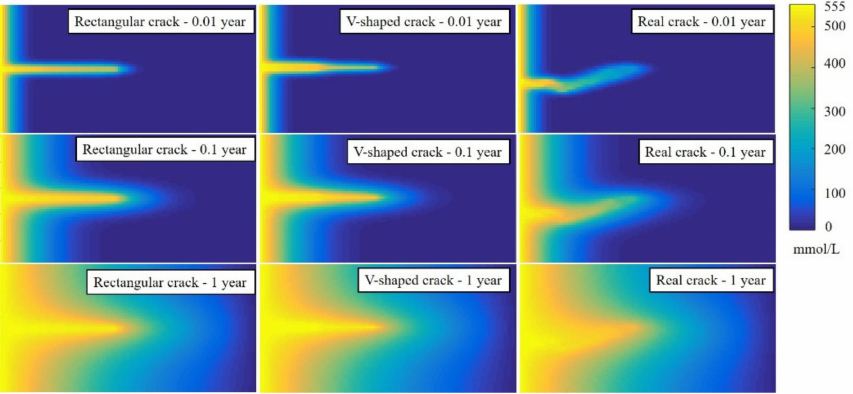
Figure 9. The chloride concentration distribution in concrete with different crack geometries.